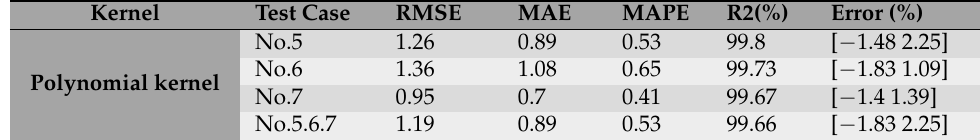
Table 2. Results of the estimation.